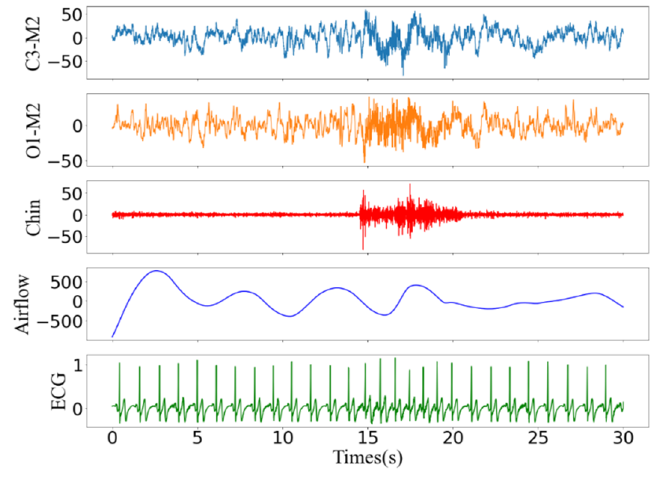
Figure 1. EEG channel diagram during arousal event .